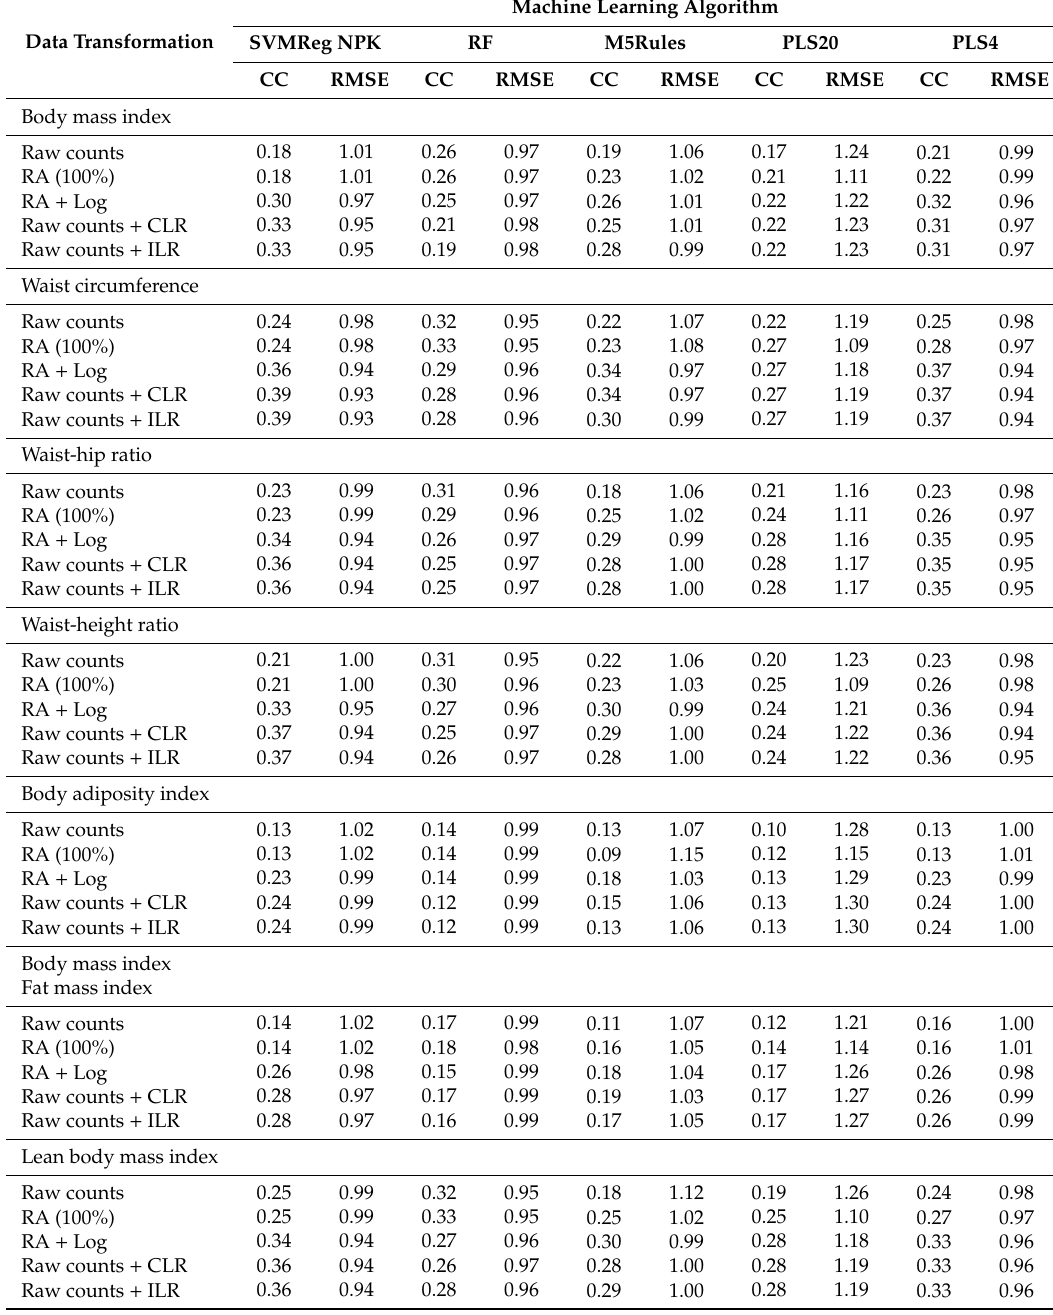
Table 2. Comparison of adiposity measures, transformation methods of operational taxonomic unit (OTU) count data, and machine learning algorithms in the study population ( n = 1923): Each method includes 10-fold cross-validation, and for each logarithmic transformation, one pseudocount was added to the raw counts. CC: correlation coe ffi cient; CLR: centered log-ratio transformation; ILR: isometric log-ratio transformation; NPK: normalized poly kernel; PLS: partial least squares regression; RF: random forest; RA: relative abundance; RMSE: root mean squared error; SVMReg: support vector machine